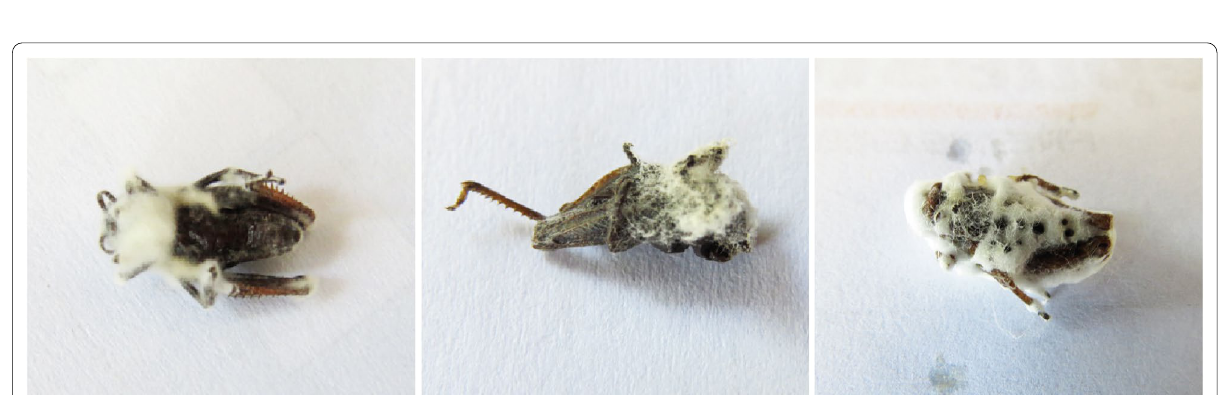
Fig. 2 Nymphs of Bufonacris claraziana infected with Beauveria bassiana